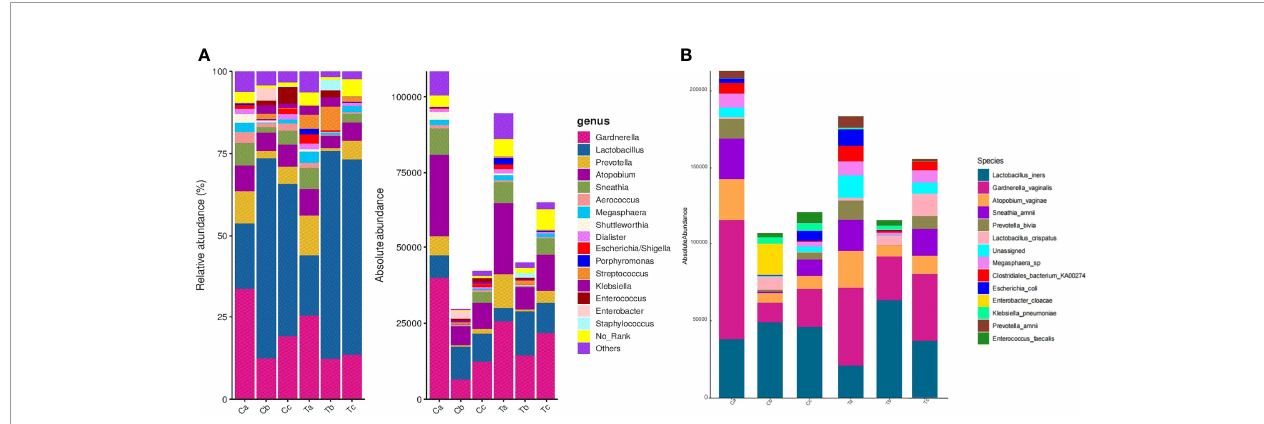
FIGURE 4 | Relative and absolute abundances of the major taxa at the genus (A) and the species (B) levels in Clindamycin and Furong groups.(Ta, Tb, and Tc represent stages V1, V2, and V3 of the Furong group, respectively; Ca, Cb, and Cc represent stages V1, V2, and V3 of the Clindamycin group, respectively).